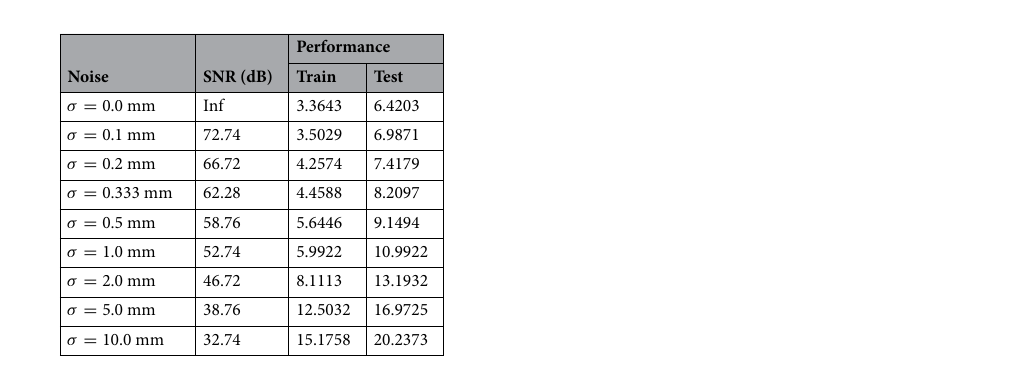
Table 2. Estimation performance of the RCEN under different measurement